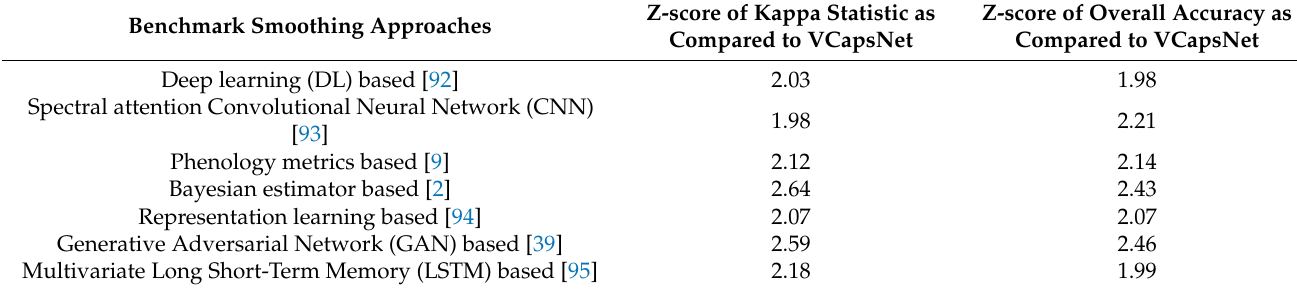
Table 3. Z-score-based significance analysis of variational capsule network (VCapsNet) in comparison with the benchmark deep learning (DL) classifiers *.